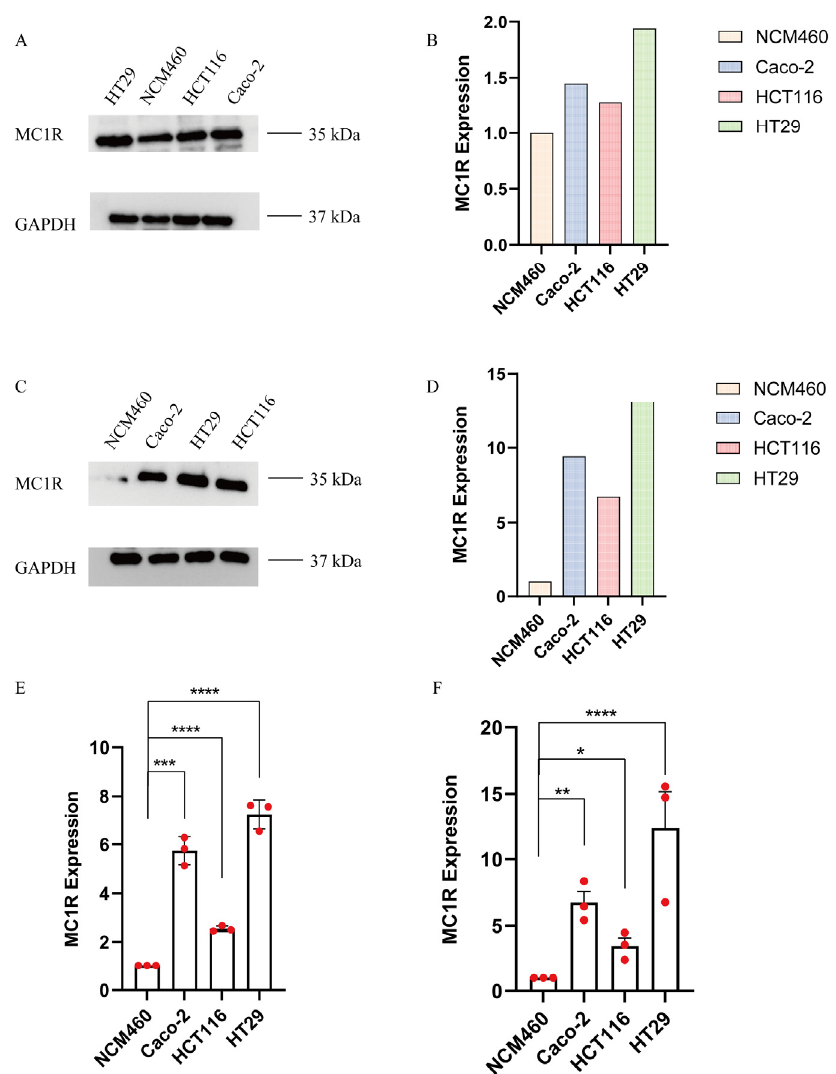
Figure 6. The expression of MC1R was detected by WB and qPCR. ( A , B ) Protein expression of MCIR in 2D cell lines; ( C , D ) protein expression of MCIR in organoids; ( E ) expression of MCIR in 2D cell lines by qPCR; ( F ) expression of MCIR in Organoids by qPCR (the results were repeated three times, shown as mean ± SEM; * significant differences at p < 0.05; ** significant differences at p < 0.01; *** significant differences at p < 0.001; **** significant differences at p < 0.0001). The red dots represent the values of the sample.